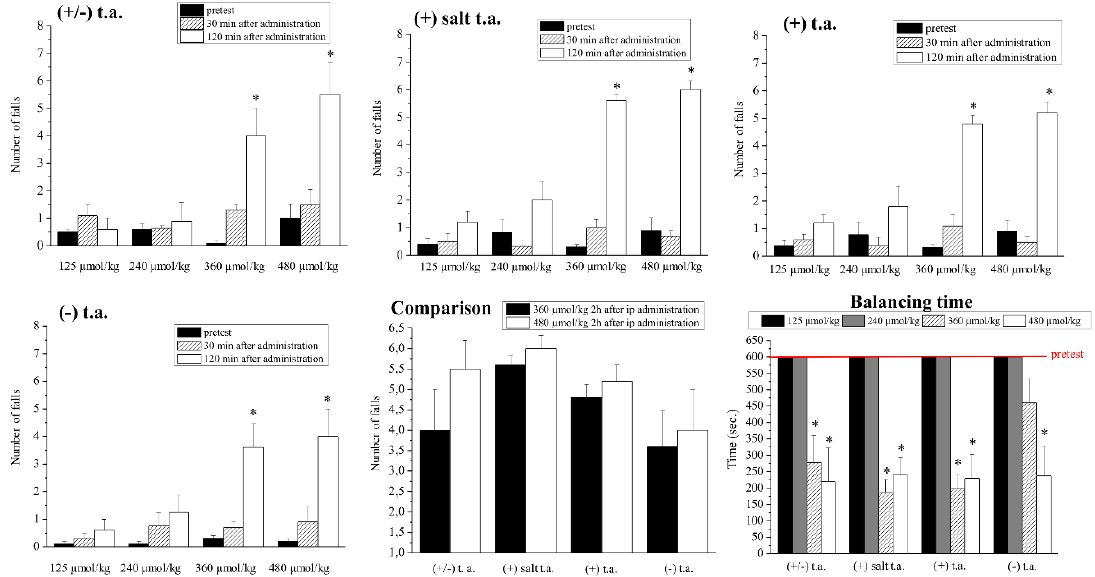
Figure 2. Effects of acute toxicity treatments: ataxia (Rota Rod test). The graphs represent: the number of falls observed 30 and 120 min after treatments with increasing concentrations (125, 240, 360 and 480 µmol/kg) of thioctic acid (t.a.) isoforms (racemate, (+) tromethamine salt enantiomer, (+) acid enantiomer, (−) enantiomer); a comparison among all groups of treatments at 360 and 480 µmol/kg two hours after the injection ; the time of balanced walking after 2 h. Each value represents the mean ± SEM of 6 rats per group. * p < 0.05 vs pretest.